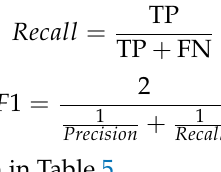
Table 5. Model performance comparison of algorithms.